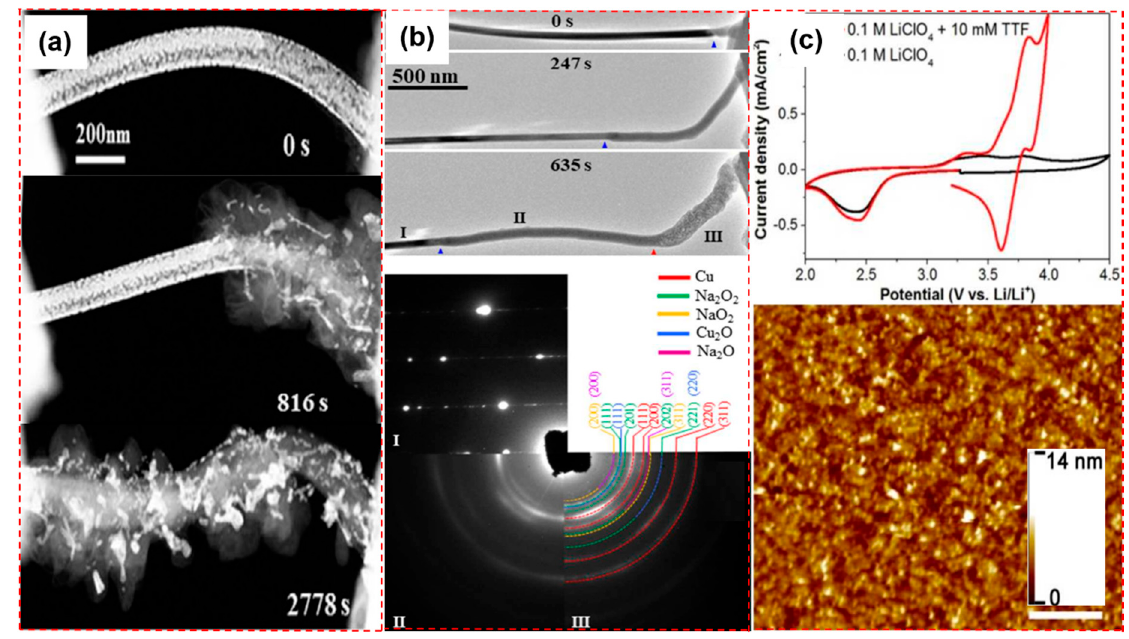
Figure 9. ( a ) Structure evolution of the NaO 2 discharge product during oxygen reduction reaction (ORR) [46] (Copyright © 2019, Elsevier); ( b ) Structural and phase characterization of a CuO nanowire (NW) during discharging and charging in an O 2 environment [47] (Copyright © 2018, American Chemical Society); ( c ) Cyclic voltammetry performed in electrochemical-atomic force microscope cell and the resulting AFM image after CV reduction [48] (Copyright © 2016, American Chemical Society).